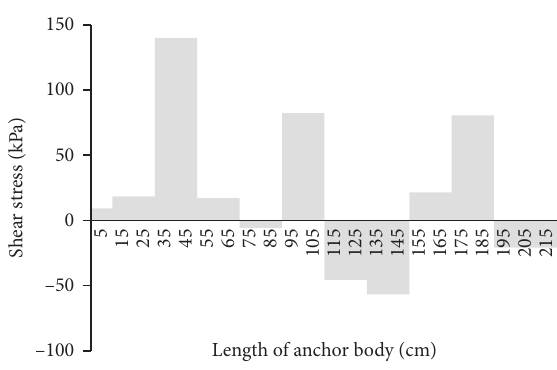
Figure 16: Shear stress distribution of anchor 190cm.